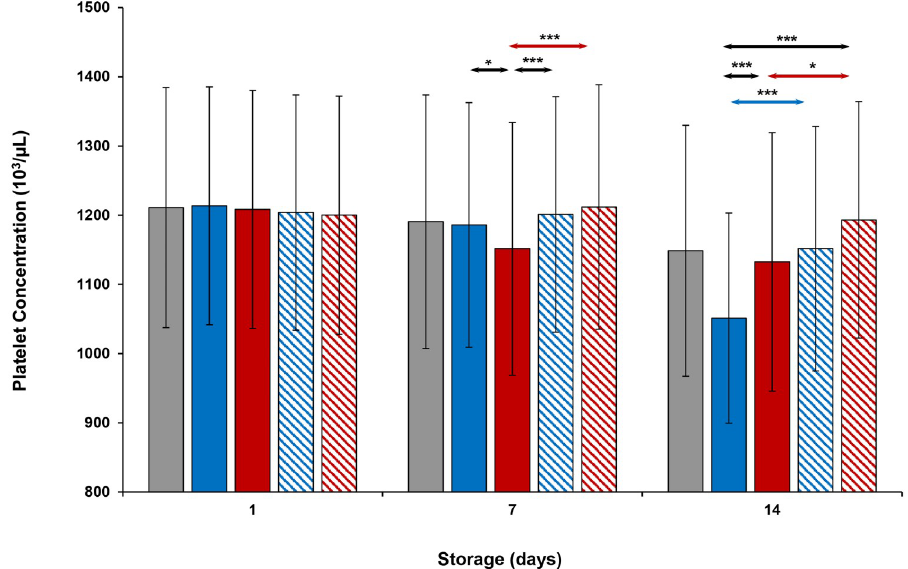
Fig 1. Effects of 14-day storage, temperature and presence of p38MAPK inhibitor on platelet concentration. Grey bar–platelets stored at room temperature; blue solid bar–cold-stored platelets; red solid bar–thermocycled-stored platelets; blue striped bar–cold-stored + VX-702 platelets; red striped bar–thermocycled-stored + VX-702 platelets. Data represents the mean of 15 experiments with one standard deviation. Arrows represent paired statistical differences; � —p < 0.05, ��� —p < 0.001.